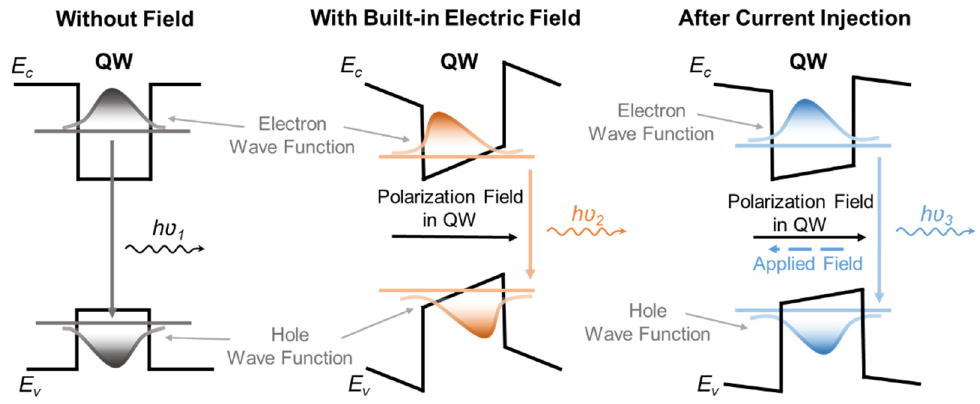
Figure 1. The schematic diagram of the quantum-confined Stark effect (QCSE) in InGaN-based mi- cro-LEDs.